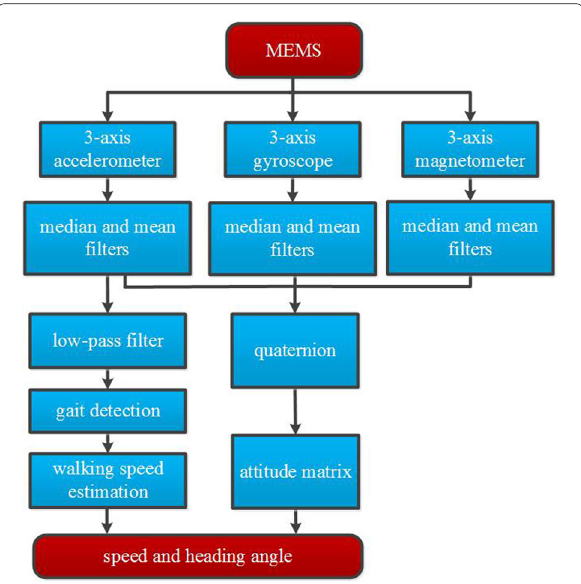
Fig. 7 Process of speed and heading estimation